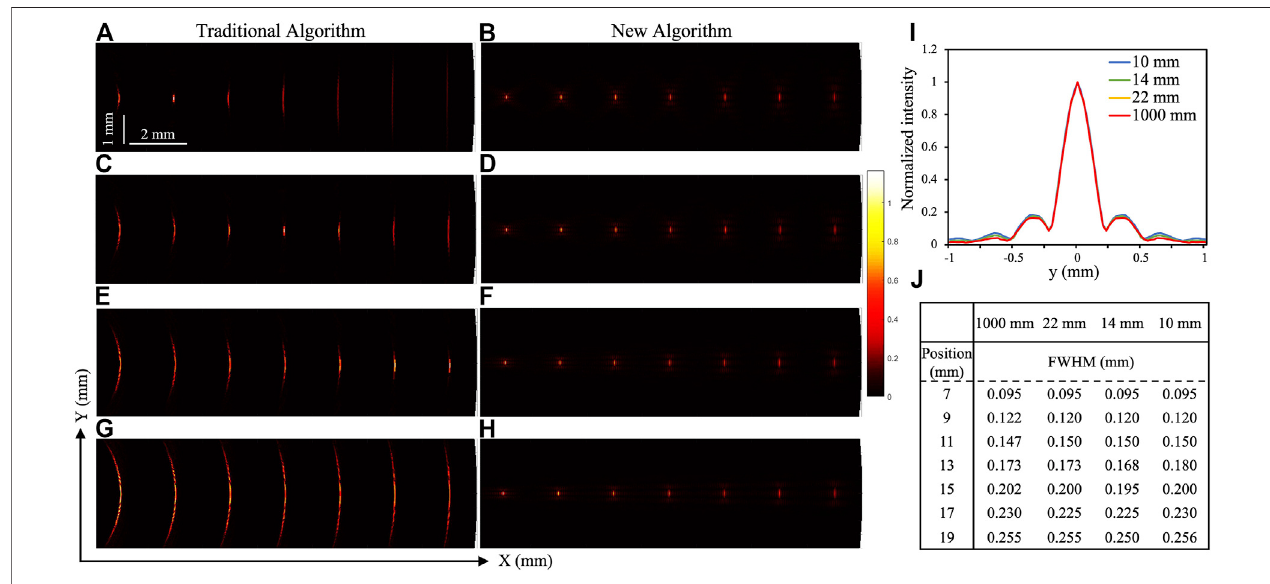
FIGURE 3 | Simulated photoacoustic imaging results in the X – Y direction. (A,C,E,G) The imaging results simulated by traditional PAE reconstruction algorithm under focuses of 10, 14, 22, and 1,000 mm, respectively. (B,D,F,H) The imaging results simulated by improved PAE reconstruction algorithm under focuses of 10, 14, 22, and 1,000 mm, respectively. (I) The lateral pro fi les for the seventh target (from left to right; at 19 mm) obtained from (B,D,F,H). The blue, green, yellow, and red lines represent the results of 10, 14, 22, and 1,000 mm, respectively. The amplitudes of these lines are normalized to 1 for comparison. (J) The FWHM value of each targets along the Y direction in